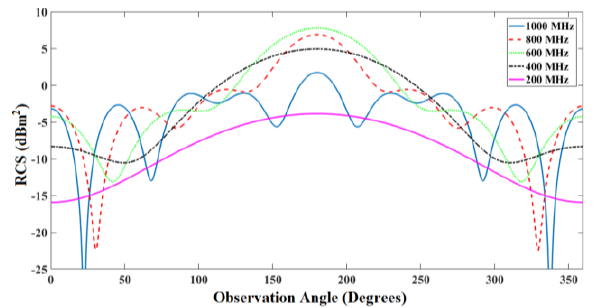
Figure 11: Wideband RCS results of a lossless scatterer.